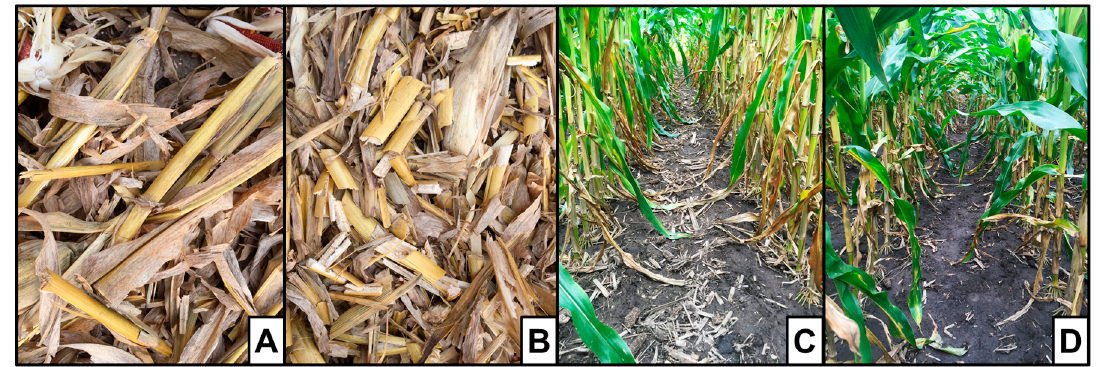
Figure 1. Mechanical residue management effects in continuous corn the previous fall (A and B) and at the R3 growth stage the following growing season ( C and D ) due to standard stalk rollers (A and C) and Calmer’s BT chopper stalk rollers ( B and D ) at Champaign, IL, USA.